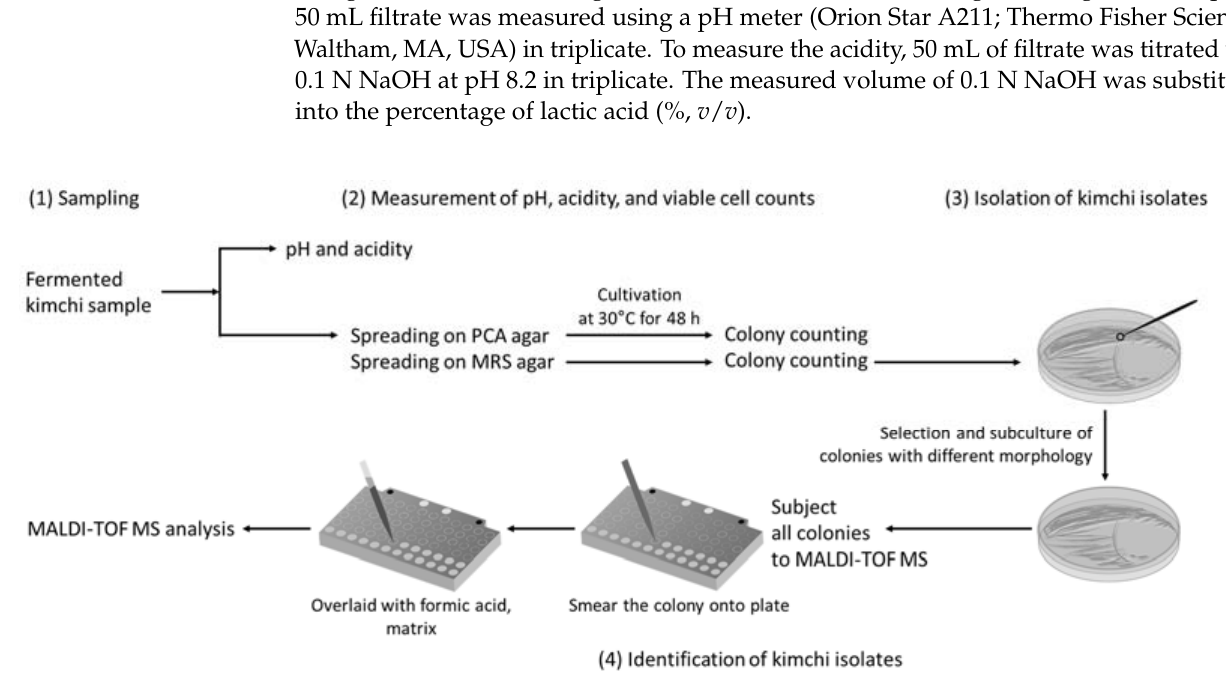
Figure 1. Diagram for analyzing the cultivable microbial community in kimchi. The strategy to identify microbial community involves: (1) Sampling, (2) Measurement of and viable cell counts, pH, and acidity, (3) Isolation of kimchi isolates, and (4) Identification of kimchi isolates.